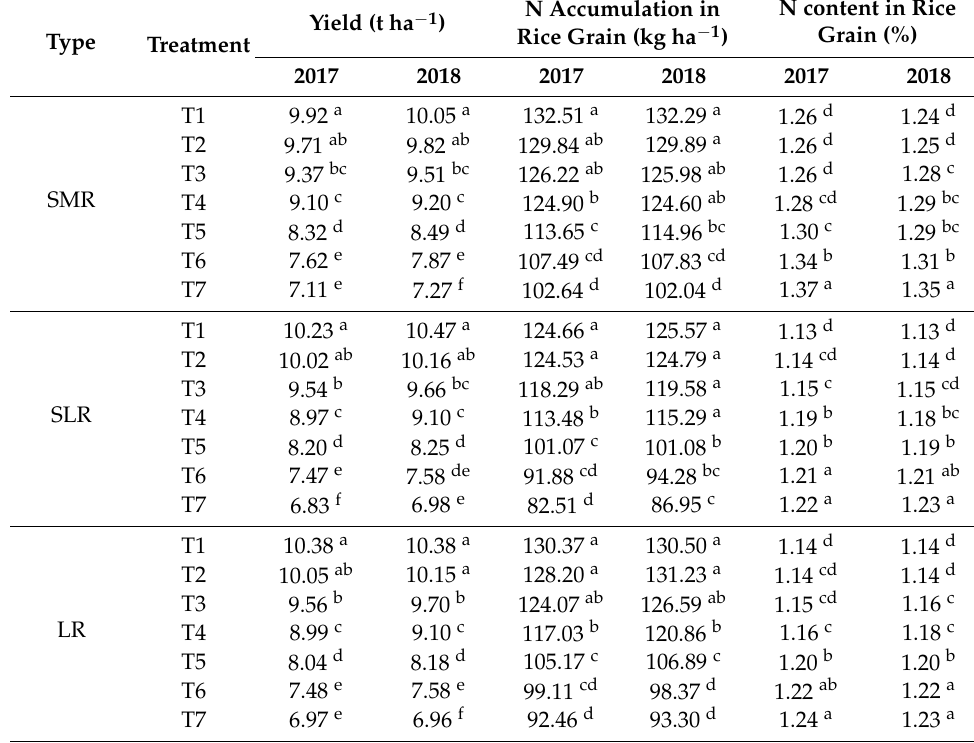
Table 5. Effects of T and R on rice yield and N accumulation of different types of rice 1